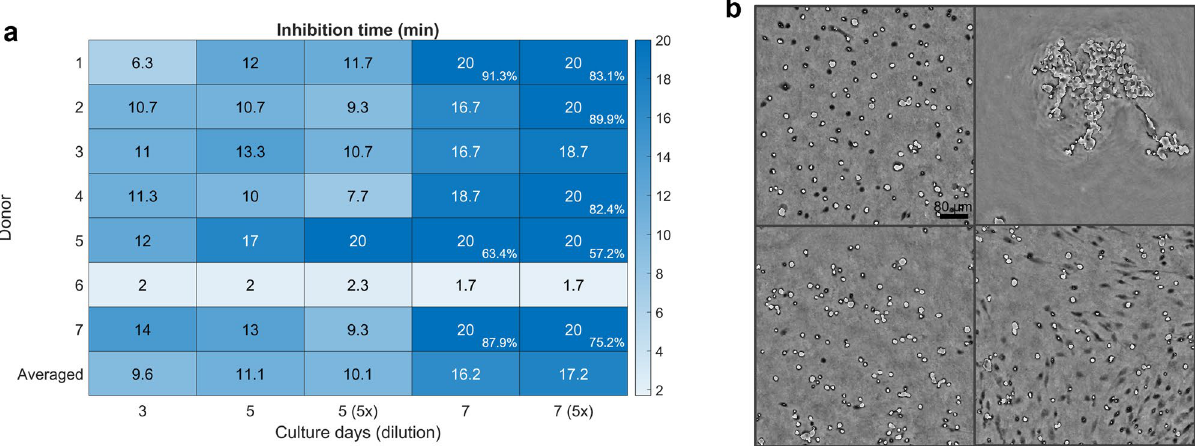
Figure 8. Inhibition times extracted using the threshold approach. ( a ) Heat map of the inhibition time for the different conditions. In case the threshold was not reached within the 20-min harvesting period, the final percentage of detached cells was indicated in the bottom-right corner. ( b ) Four examples of phase images at their corresponding inhibition times. Top left: donor 2 (day 5, no dilution). Top right: donor 6 (day 5, diluted). Bottom left: donor 3 (day 7, diluted). Bottom right: donor 5 (day 7,